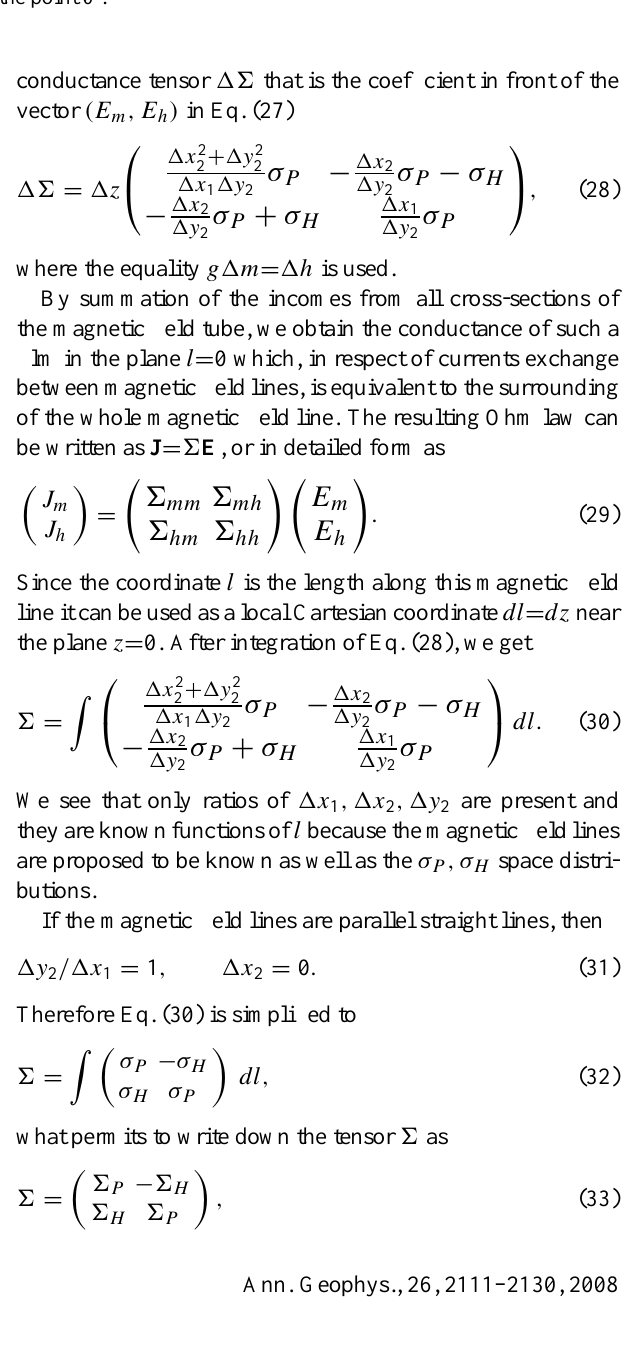
Fig. 3. Normal cross-sections of a magnetic field tube which starts at the m,h plane. The right panel presents another cross-section of the same tube. The local Cartesian coordinates x,y,z are introduced near the point 0 0